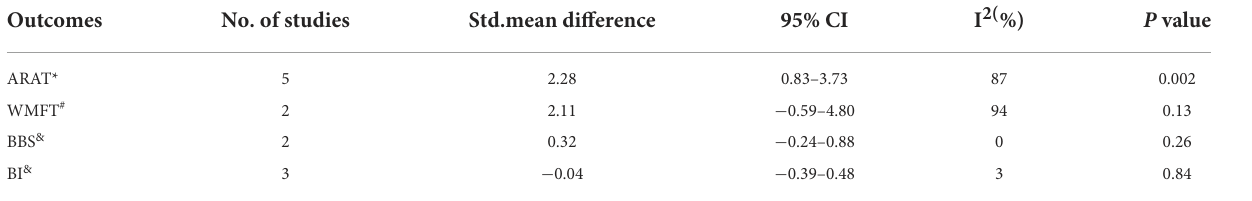
TABLE 3 Secondary outcomes of iTBS for stroke.